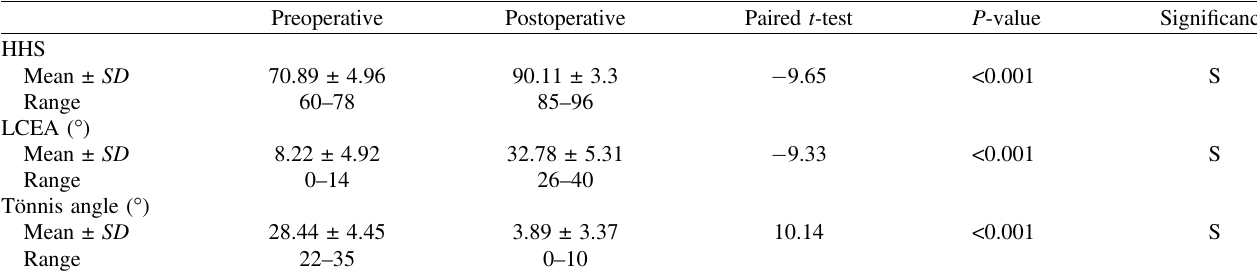
Table 2. Summary of HHS and radiographic